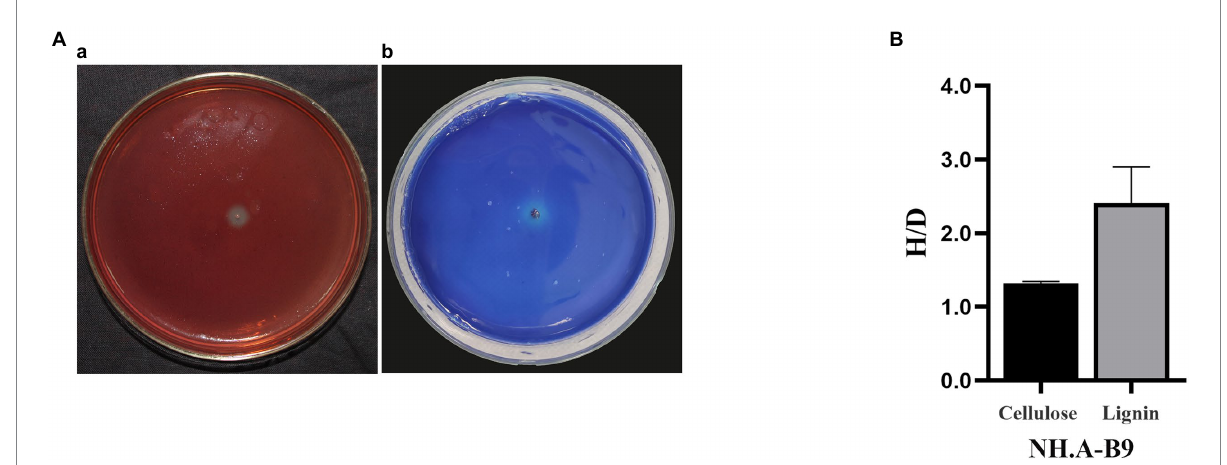
FIGURE 5 Degradation of cellulose and lignin by Acinetobacter (NH. A-B9). (A) Degradation images of NH. A-B9. (a) NH. A-B9 degraded cellulose. (b) NH. A-B9 degraded lignin. (B) The cellulose hydrolase activity and laccase production capacity of NH. A-B9 were initially determined based on the ratio of H and D (H/D). The error bars represented the standard deviation.